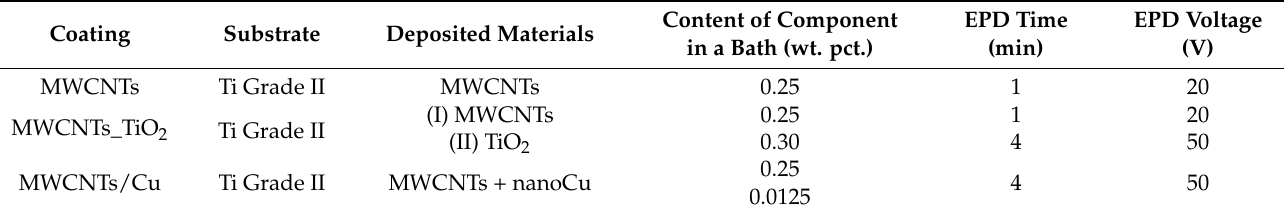
Table 1. Parameters of synthesis of